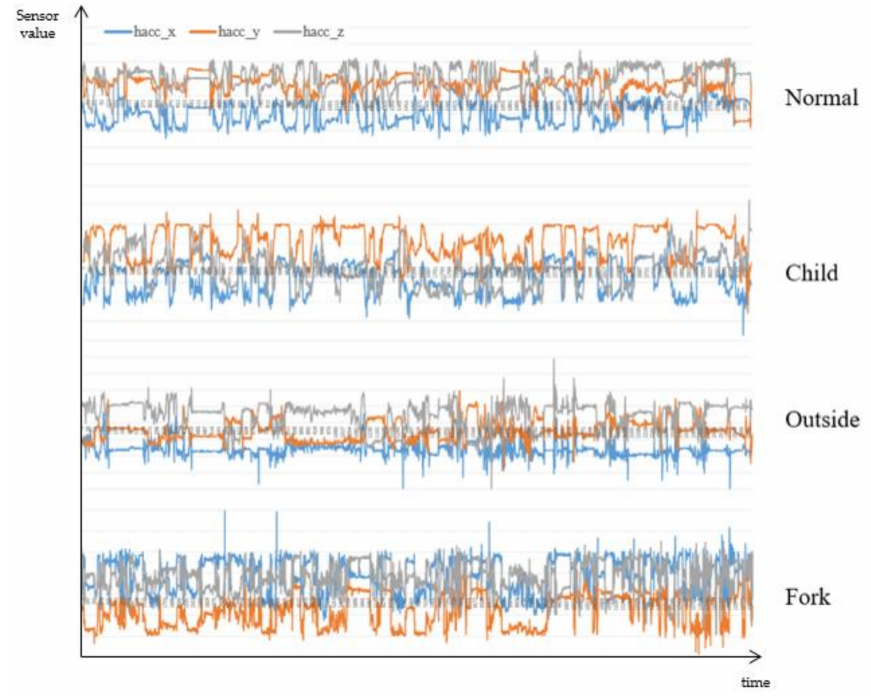
Figure 1. A time-series variation of acceleration sensor data in various activities.